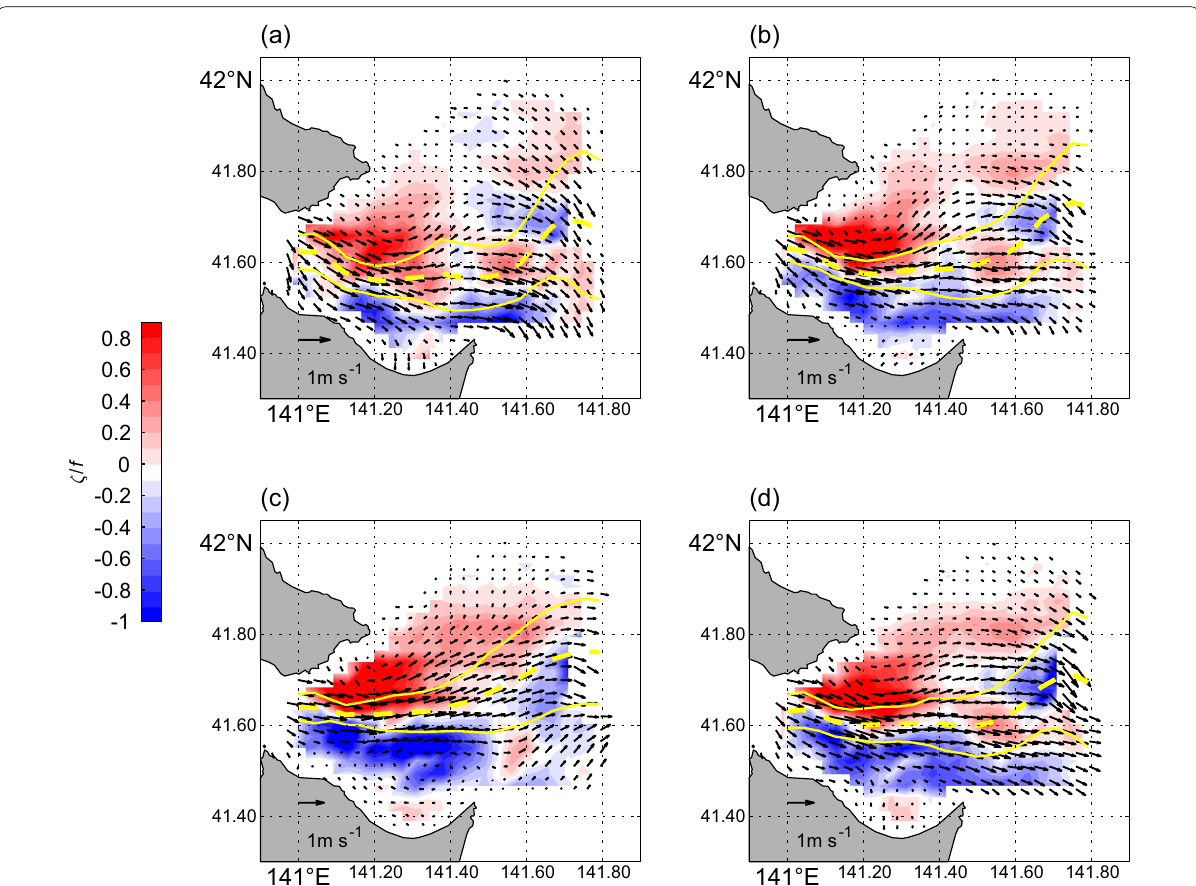
Fig. 4 Seasonal mean of the surface velocity obtained from the high-frequency radar data in a winter, b spring, c summer, and d autumn. The color denotes the relative vorticity estimated from the radar data as ∂ v /∂ x ∂ u /∂ y , where u and v are the zonal and meridional velocities, respectively. The − yellow dashed (solid) line shows the temporal mean (standard deviation) of the Tsugaru Warm Current axis. The bathymetry is along